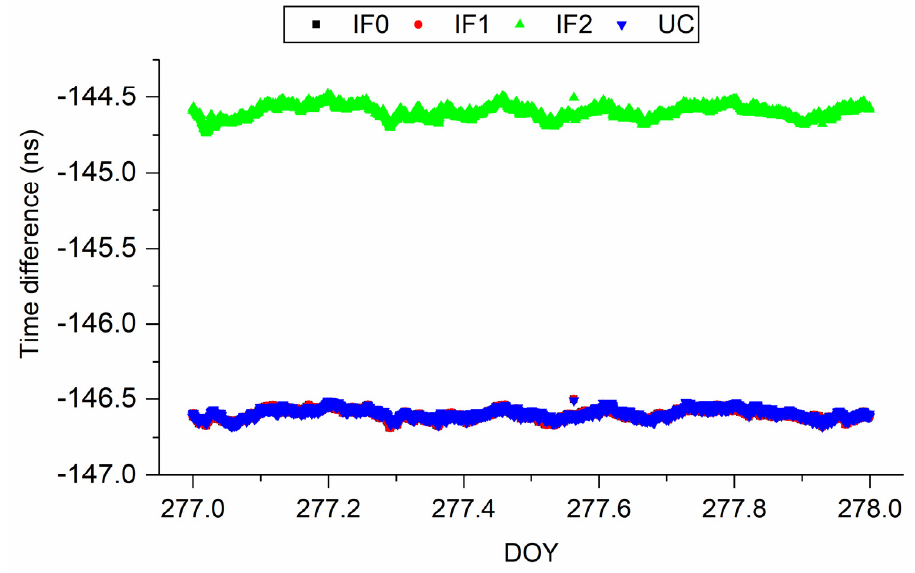
Figure 10. Comparison of time difference of PTBB-PT11 obtained from different models on DOY 277, 2019. Table 5. Mean and STD values of time difference with different Galileo PPP models for BRUX-PT11 (ns).